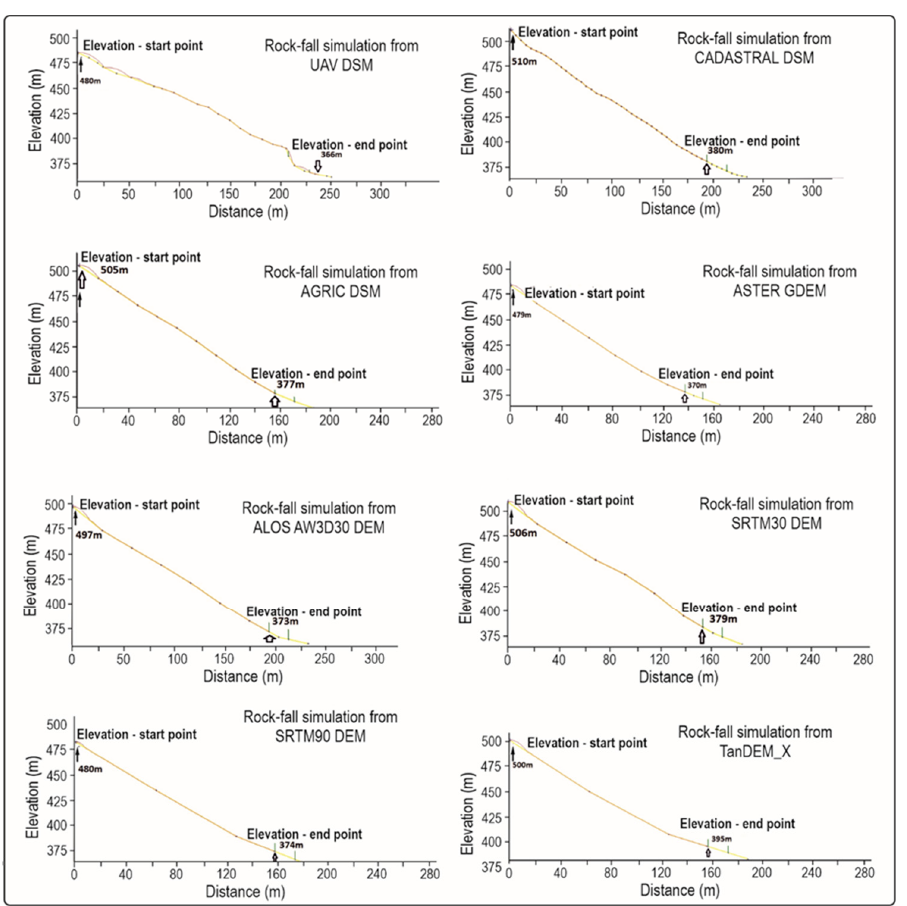
Figure 19. Two-dimensional rockfall simulations via RocFall software for the 2nd slope